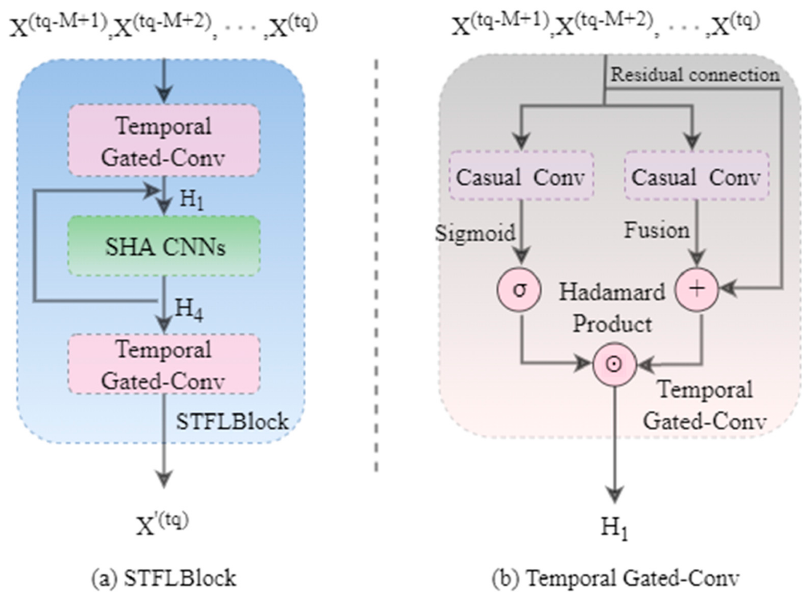
Figure 2. The overview of STHGNN.